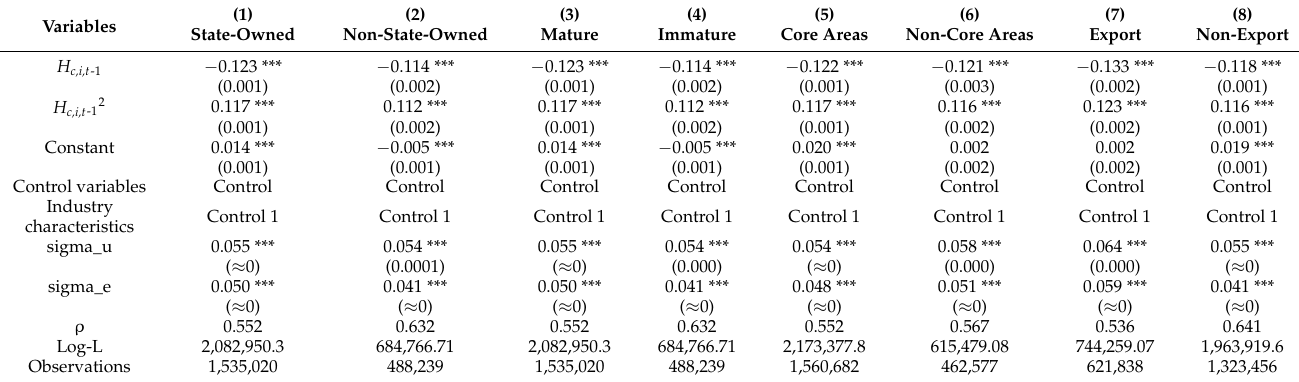
Table 5. Environmental compliance and enterprise innovation: Heterogeneity test results.